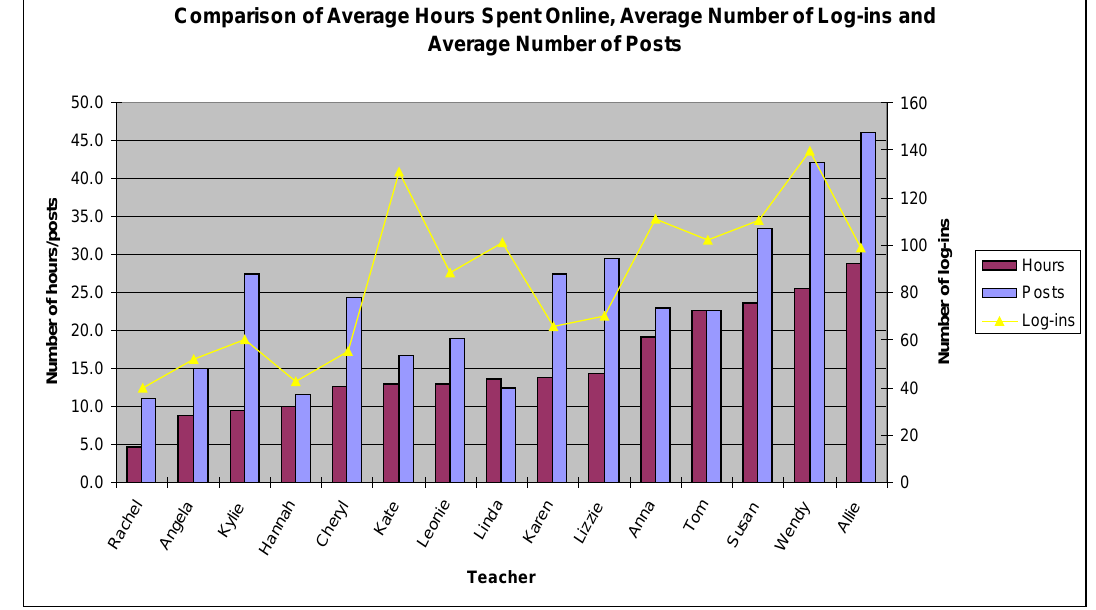
Figure 2. Analysis of online participation using quantitative measures